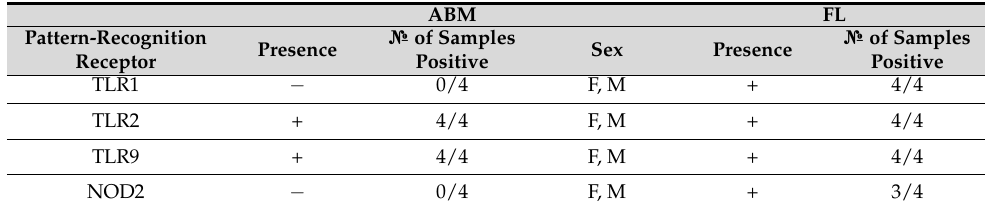
Table 3. Pattern-recognition receptor mRNAs in CECs. Data are presented as either presence (+) or absence ( − ), number of samples containing the mRNA and sex for adult bone marrow donors (F for female donors, M for male donors). ABM–adult bone marrow CECs, FL–fetal liver parenchyma